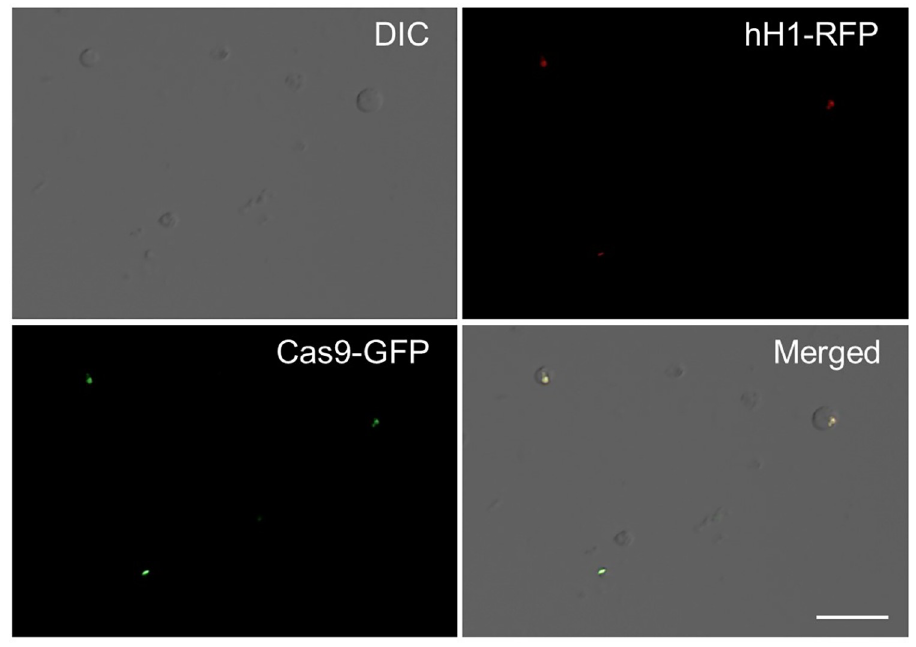
Fig 1. Subcellular localization of Cas9-eGFP protein in F . graminearum . GFP fluorescence was colocalized with histone H1-RFP in protoplasts. The results indicated that SV40 NLS is functional for the nuclear localization of Cas9 protein in this fungus. Scale bars, 20 μ